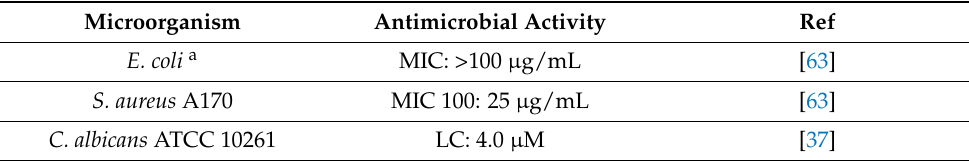
Table 4. Antimicrobial activity against selected microorganisms of peptide temporin